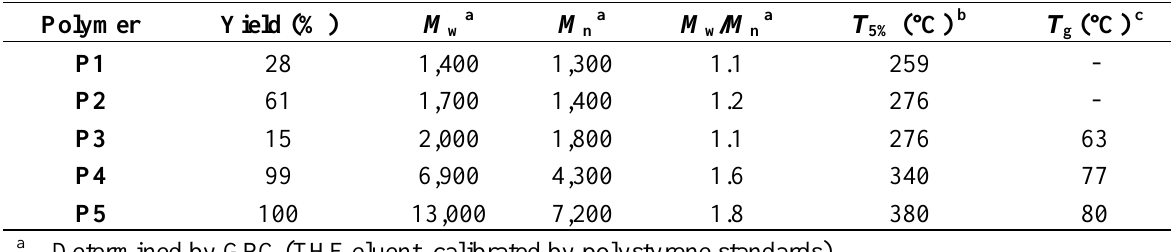
Table 1. Summary of the polymerization results and thermal